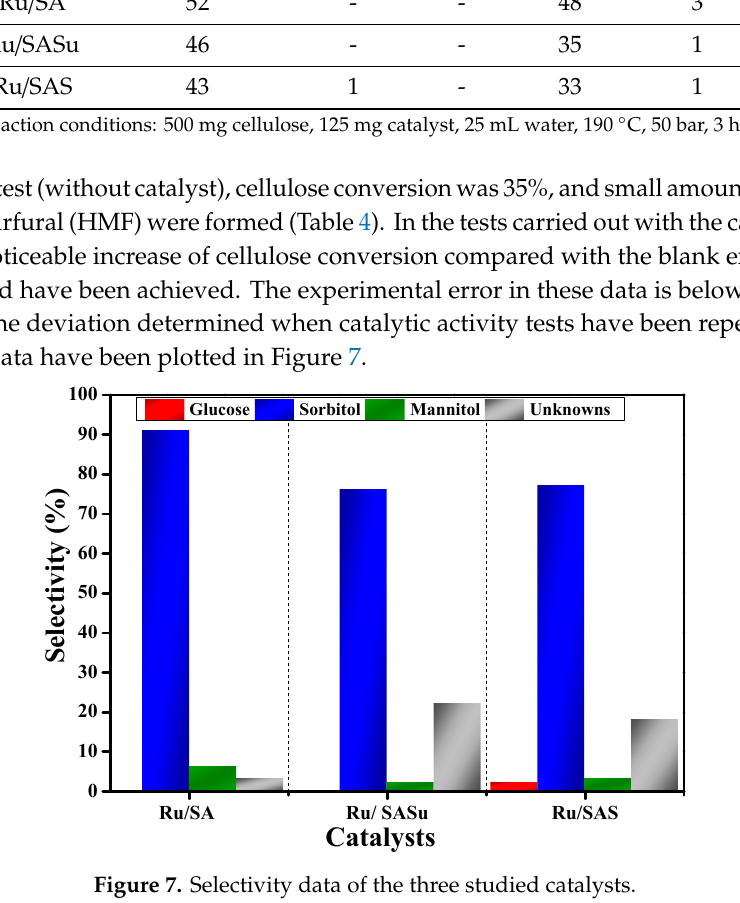
Table 4. Cellulose conversion and products yield.